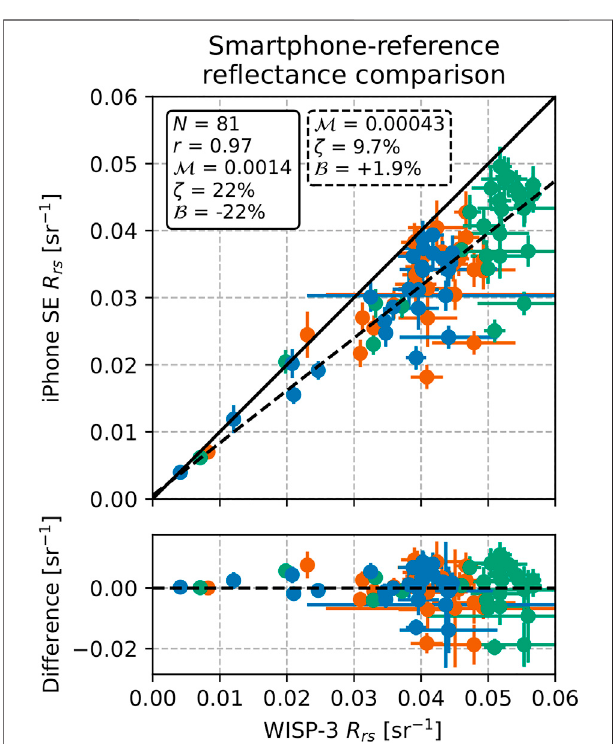
WISP-3 R rs measurements in the RGB bands. The solid line corresponds to a 1:1 relation, the dashed line is the best- fi tting linear regression line. The statistics in the solid-outline text box are based on a 1:1 comparison, those in the dashed-outline text box are based on the regression line. The differences in the lower panel are based on the regression line.